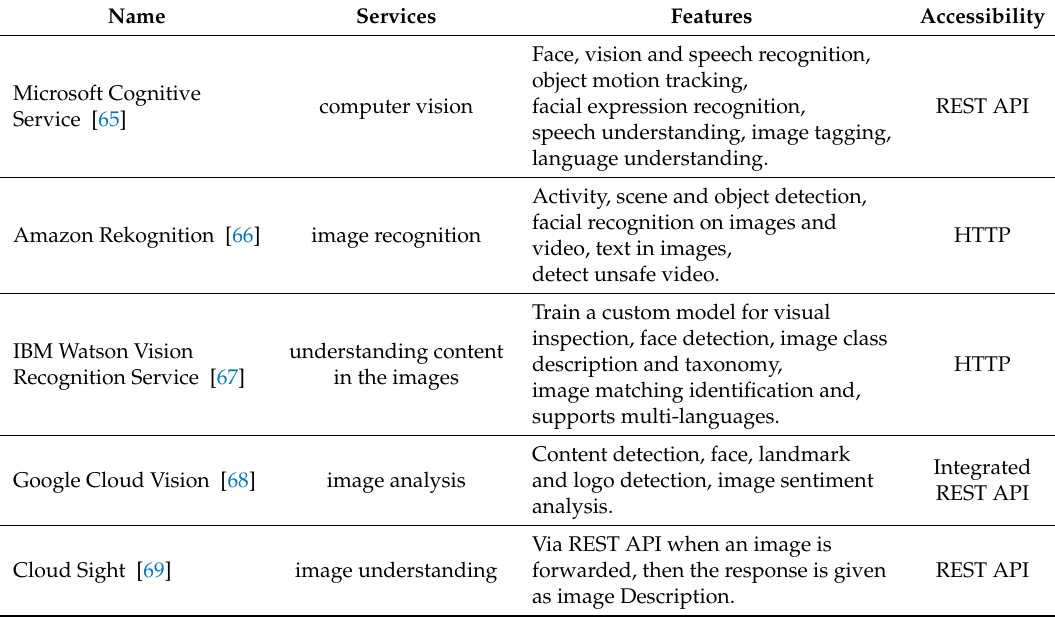
Table 4. List of available API services for object